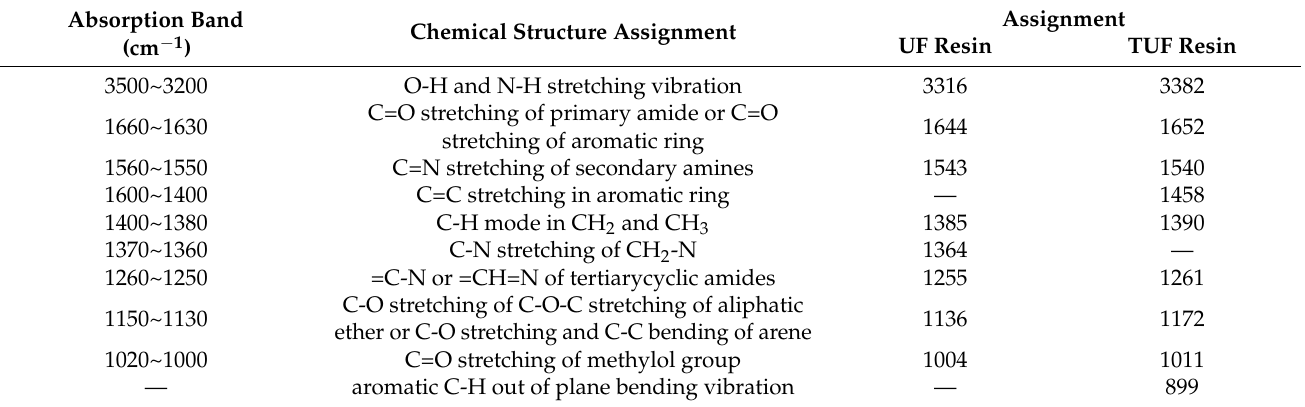
Figure 2. FT-IR spectra of UF and TUF resins. ( a ) the full spectra; ( b ) the partial enlarged spectra. Table 5. Assignments of the relevant peaks in FT-IR spectra of UF and TUF resins.